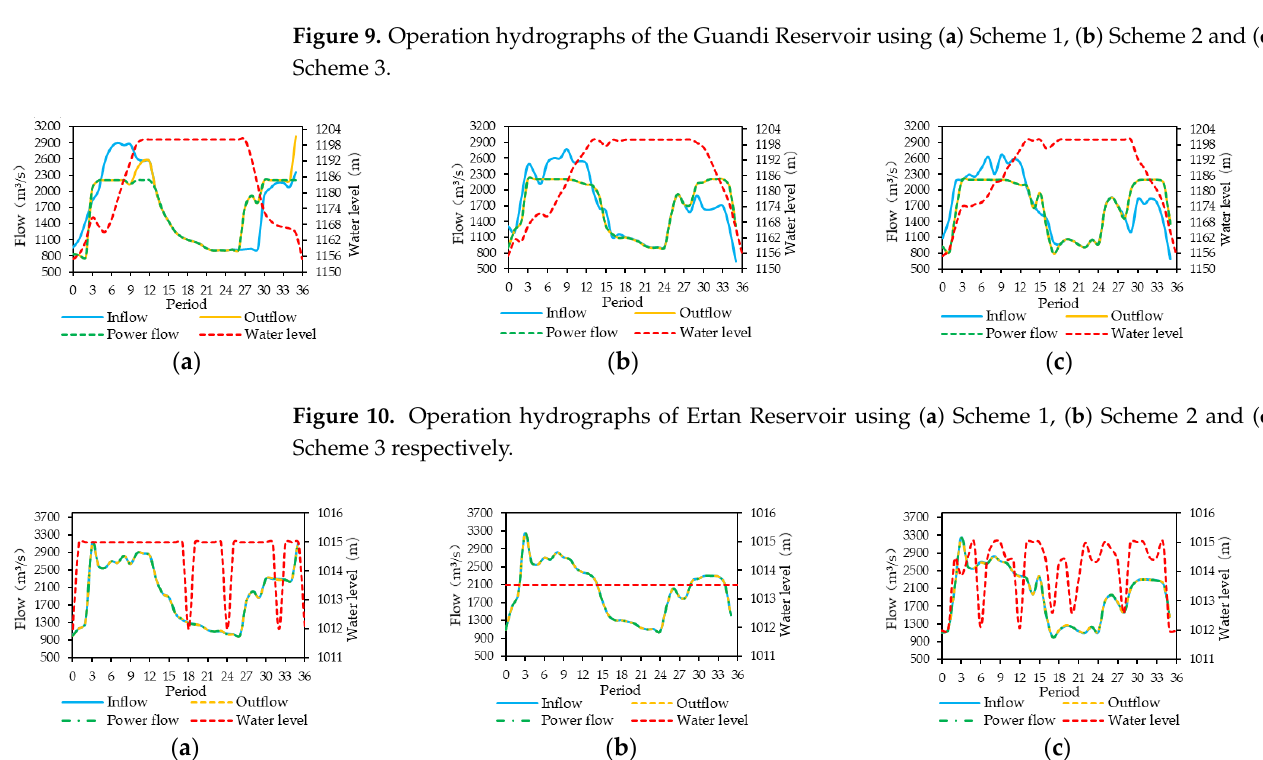
Figure 11. Operation hydrographs of the Tongzilin Reservoir using ( a ) Scheme 1, ( b ) Scheme 2 and ( c ) Scheme 3.